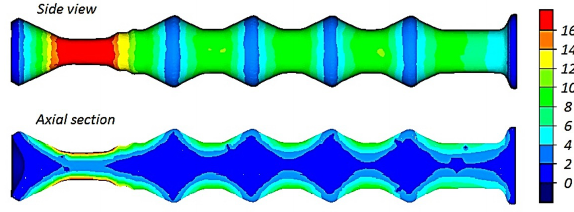
Figure 6: Distribution of the effective strain in the preform produced by skew rolling.